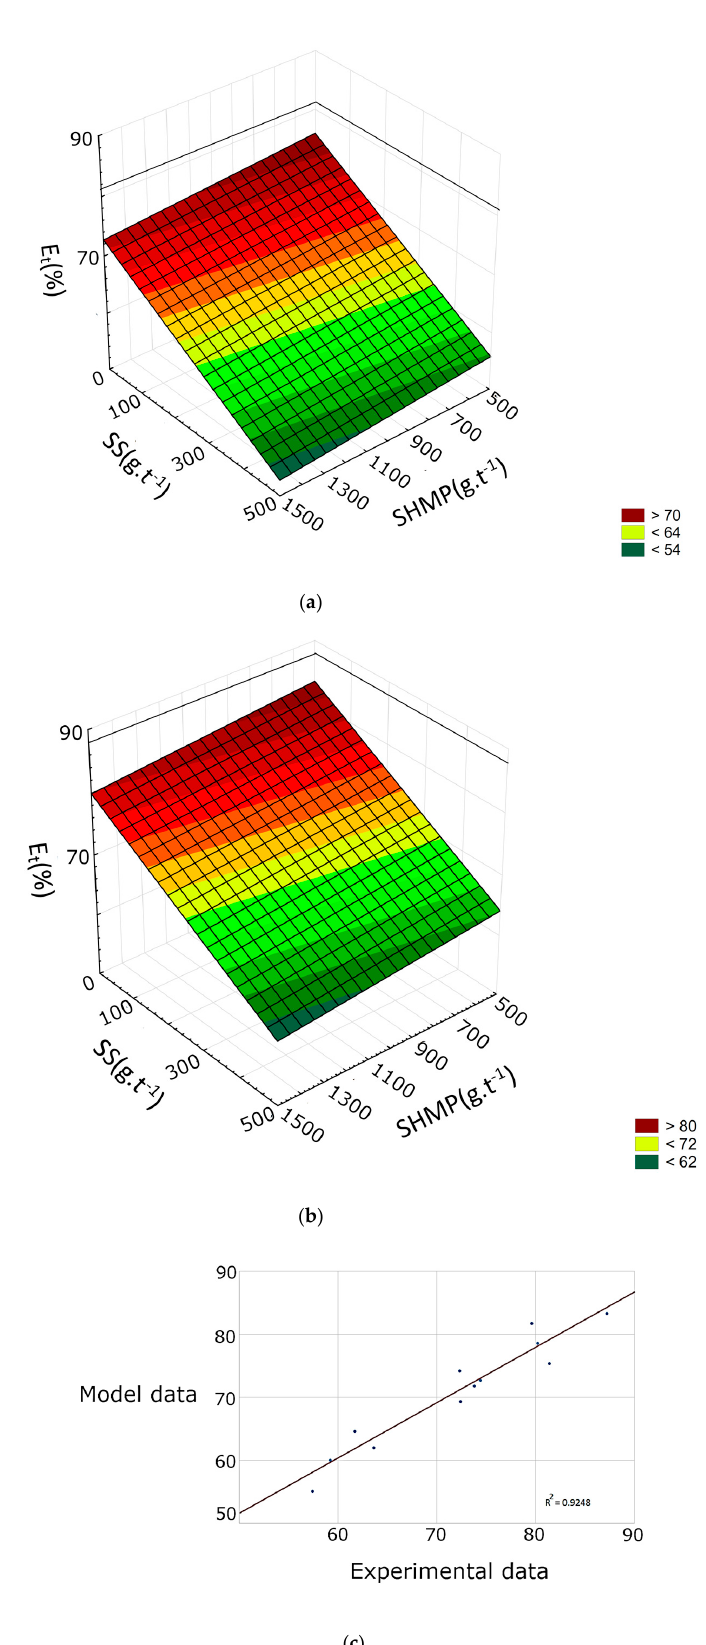
Figure 3. ( a ) (50 g.t − 1 MIBC), ( b ) (80 g.t − 1 MIBC), ( c ): Response surfaces representing the effect of SHMP and SS on the recovery of talc to froth product at different dosages of MIBC frother. The thick black lines represent the recovery of talc achieved using frother as the only reagent.